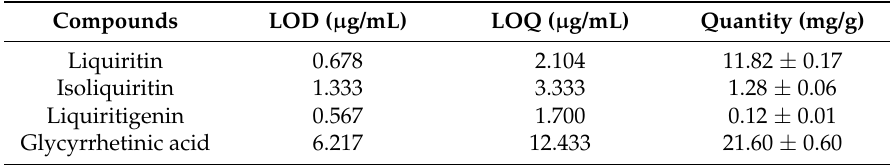
Table 2. Quantification of compounds in licorice aqueous extract by HPLC.